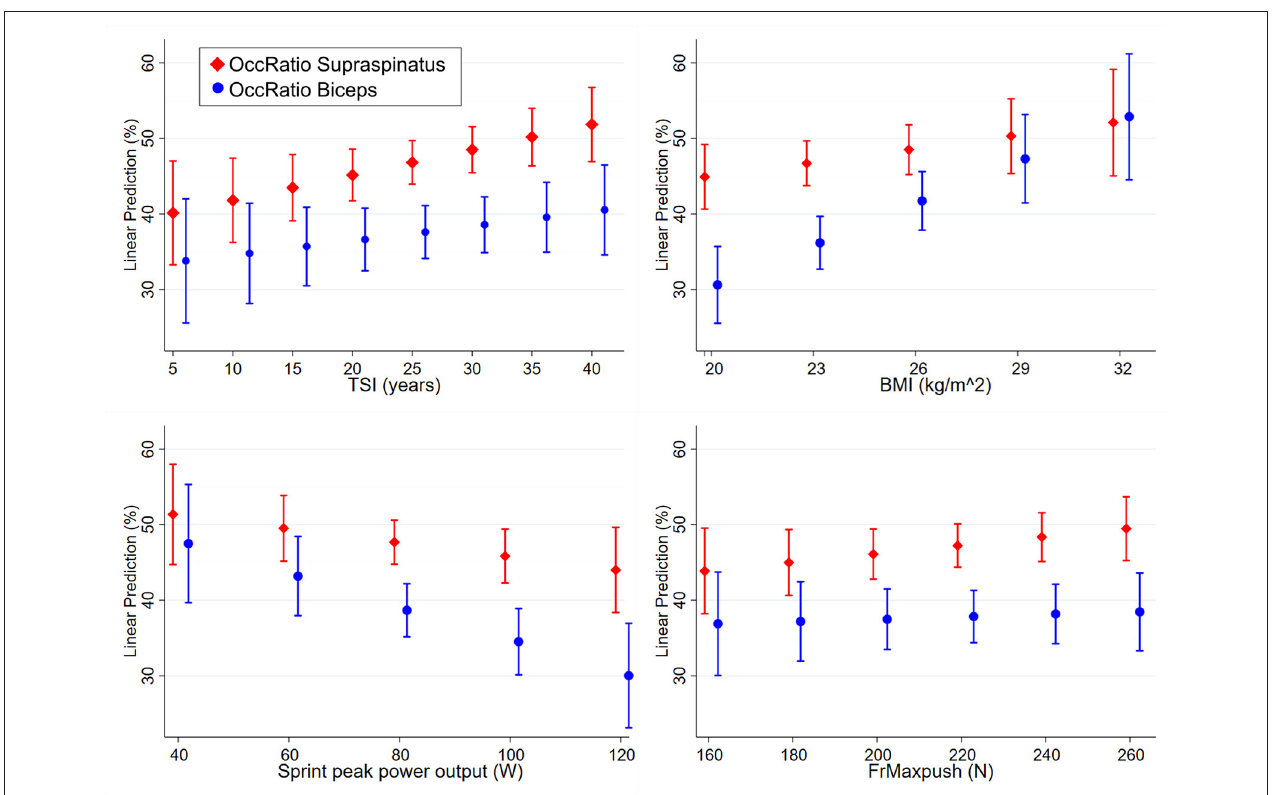
FIGURE 5 | Predictive margins with 95% confidence interval of occupation ratio (OccRatio, %) of supraspinatus and biceps for continuous covariables time since injury [(TSI), supraspinatus p = 0.025, biceps p = 0.280], body mass index [(BMI), supraspinatus p = 0.144, biceps p < 0.001], sprint peak power output (supraspinatus p = 0.288, biceps p = 0.006) and resultant force reached during maximum isometric forward pushes [(FrMaxpush), supraspinatus p = 0.251, biceps p =